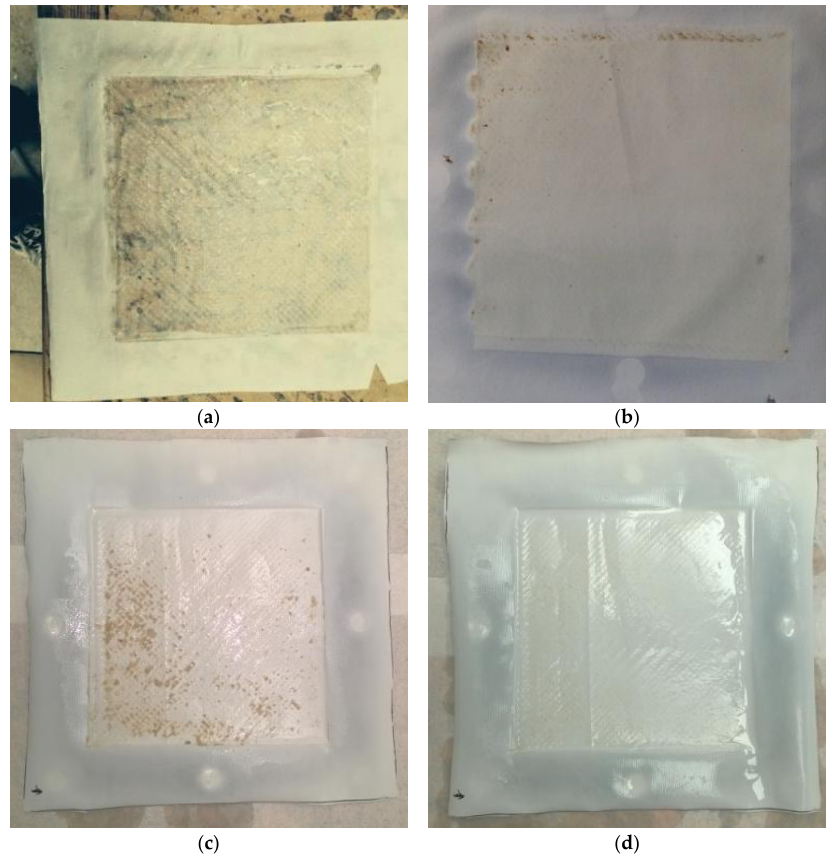
Figure 6. Photographs of membranes after treatment with PStW, showing ( a ) standard PTFE and ( b ) PU-PTFE membranes. Images show the feed contact side of the membrane, where the feed solution was fed from left to right. Photographs of PU-PTFE membrane ( c ) after MD with FStW, and ( d ) the same membrane after gentle rinse in tap water.